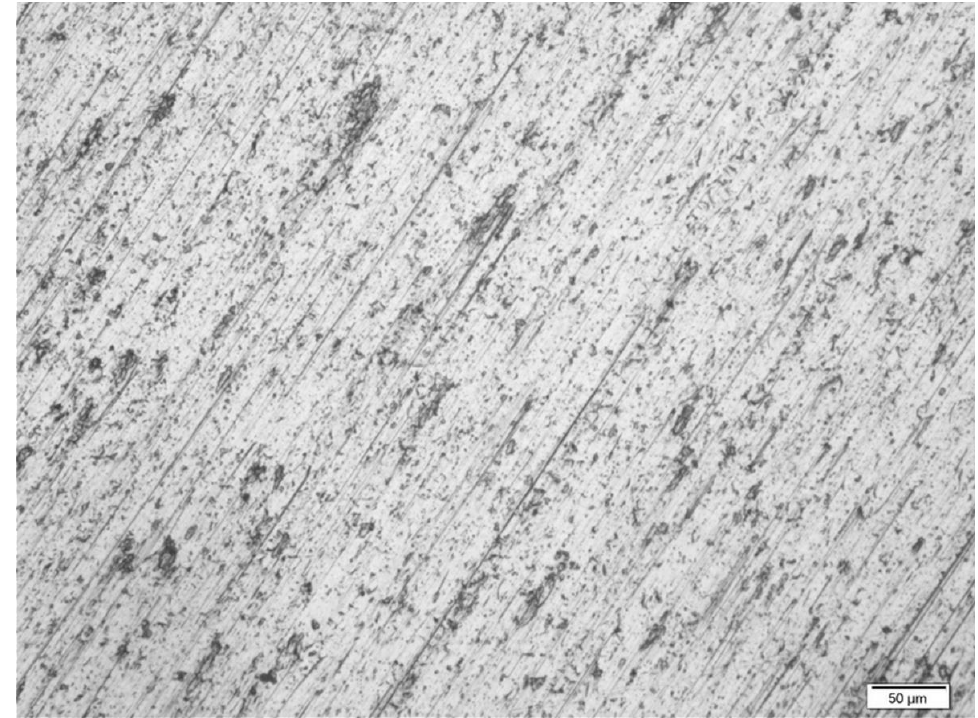
Figure 11. Structure of Ti Gr 2 (after removal of the coating) after corrosion tests in simulated body fluid. The photo was taken with the GX41 Olympus optical